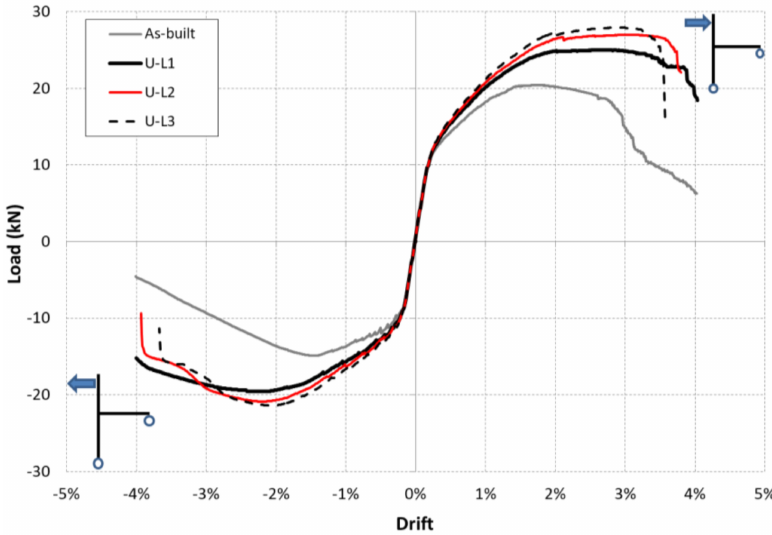
Figure 6. Comparison of the load-displacement curves in the as-built and CFRP strengthened